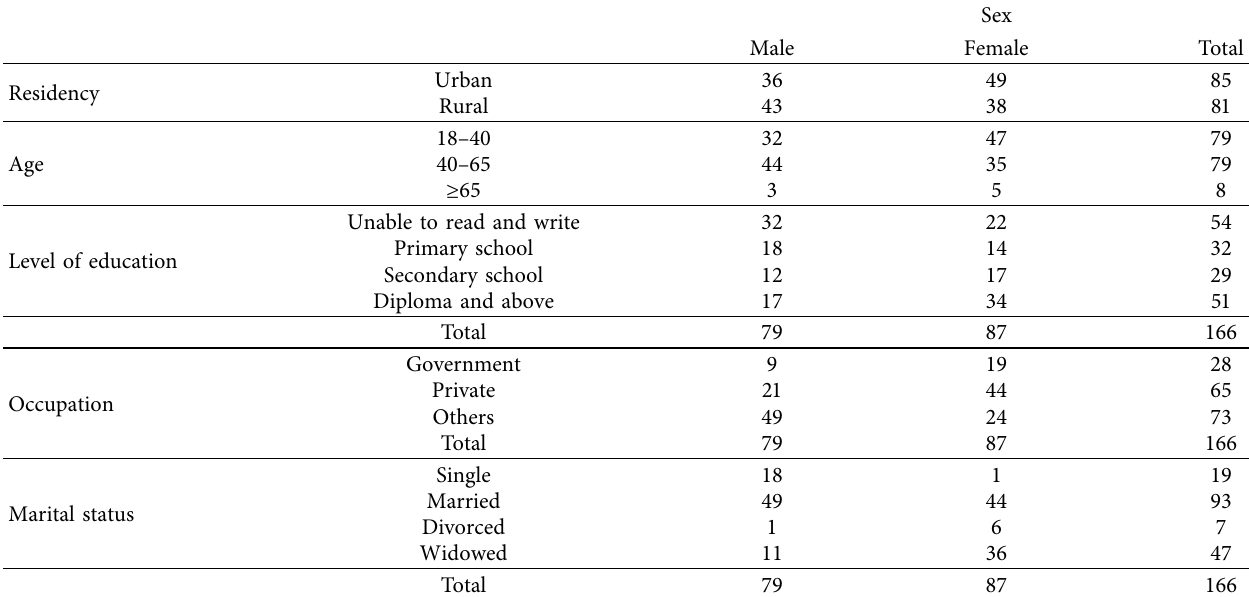
Table 1: Sociodemographic characteristics of the respondents DMCSH, 2020.